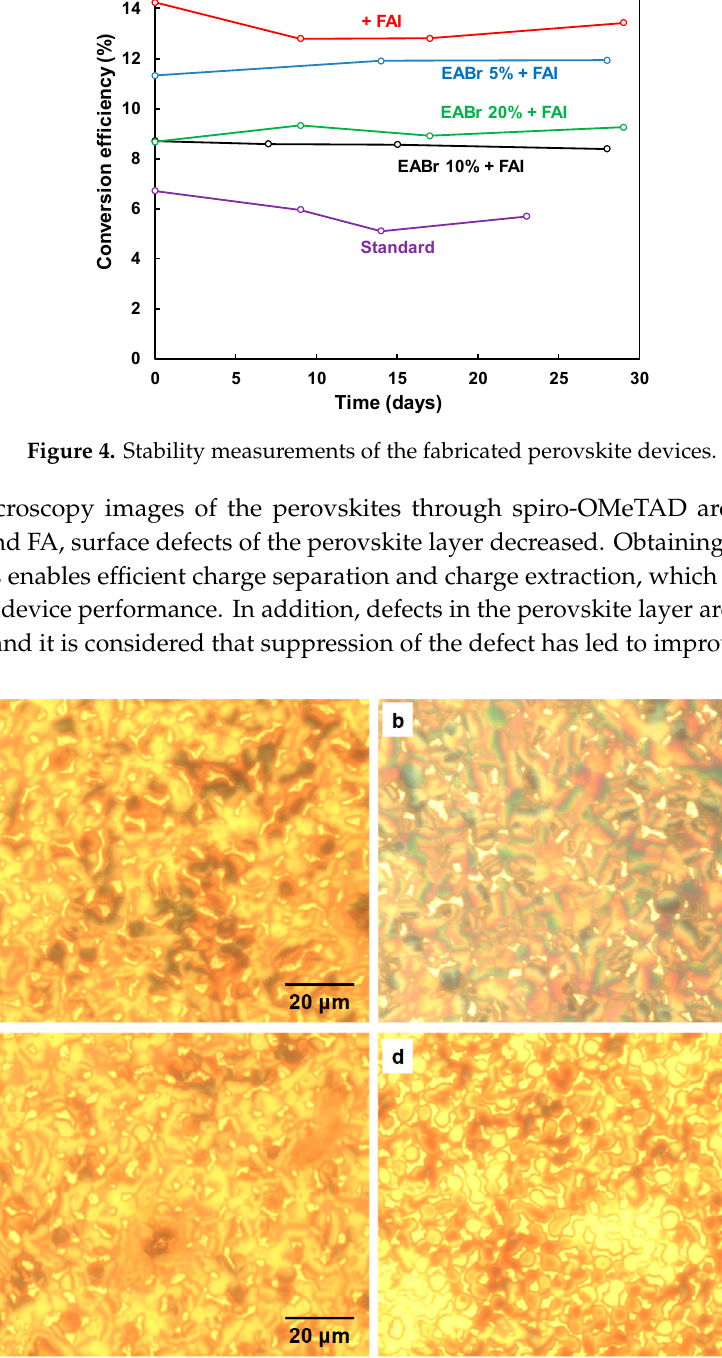
Figure 5. Optical microscopy images of cells with the compositions of ( a ) FAI 20%, ( b ) EABr 5% + FAI